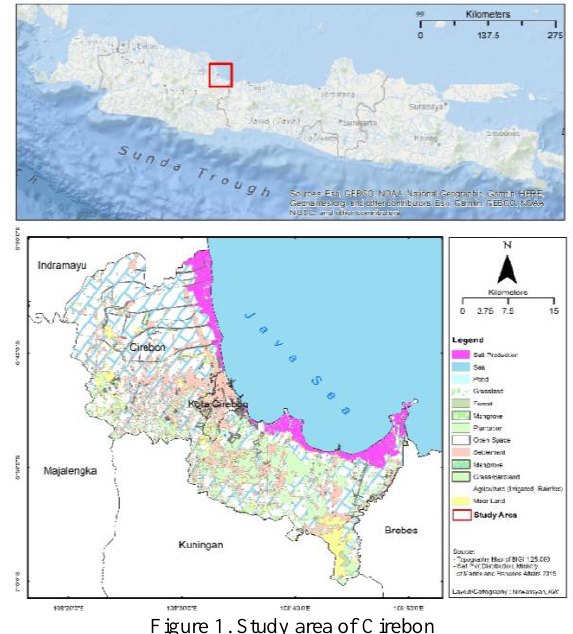
Figure 1. Study area of Cirebon